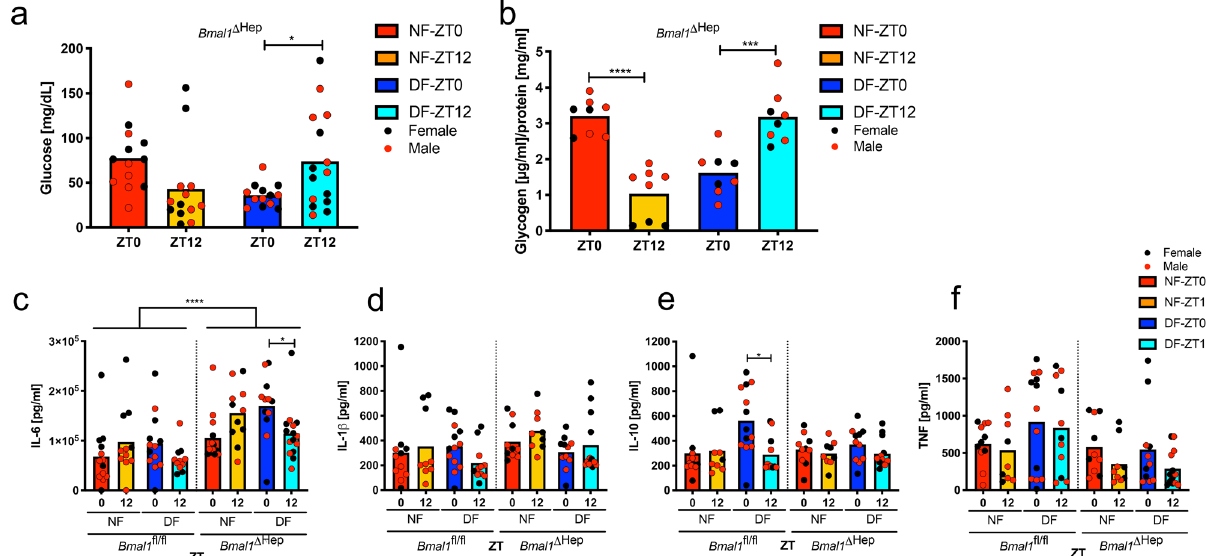
Fig. 5 Feeding-related glucose metabolism is liver-clock independent. a Serum glucose 6 h post LPS (20 mg/kg) stimulation at ZT0 or ZT12 as indicated on day 5 of TRF in Bmal1 Δ Hep . Female in black, male in red. NF-ZT0 N female = 6 N male = 7, NF-ZT12 N female = 6 N male = 7, DF-ZT0 N female = 6 N male = 7, DF- ZT12 N female = 8 N male = 7. Box indicates mean. Statistical analysis according to two-way ANOVA and Sidak ’ s multiple comparison (ZT0 vs. ZT12) as indicated. Interaction F (1,50) = 10.2, p = 0.0024, ZT F (1,50) = 0.02174, ns, Feeding F (1,50) = 0.2325, ns. * p = 0.0395. b Baseline liver glycogen content on day 5 of TRF at ZT0 or ZT12 in Bmal1 Δ Hep . Female in black, male in red. N female = 3 N male = 5. Box indicates mean. Statistical analysis according to two-way ANOVA and Sidak ’ s multiple comparison (ZT0 vs. ZT12) as indicated. Interaction F (1,28) = 64.45, p < 0.0001, ZT F (1,28) = 1.682, ns, Feeding F (1,28) = 1.431, ns. *** p = 0.0001 **** p < 0.0001. c – f Serum cytokines in Bmal1 Δ Hep or Bmal1 fl / fl 6 h post LPS stimulation (20 mg/kg) after 5 d of TRF at ZT0 or ZT12 as indicated. Box indicates mean. Female in black, male in red. Statistical analysis according to two-way ANOVA (within genotype) and Sidak ’ s multiple comparison (ZT0 vs. ZT12) as indicated. c Bmal1 fl / fl : ns. Bmal1 Δ Hep : Interaction F (1 , 47) = 11.12, p = 0.0017, ZT F (1,47) = 0.03561, ns, Feeding F (1,47) = 0.5365, ns. p * = 0.027. p < 0.0001 Bmal1 fl / fl vs. Bmal1 Δ Hep according to Mann – Whitney. Bmal1 Δ Hep : NF-ZT0 N female = 6 N male = 7, NF - ZT12 N female = 6 N male = 5, DF-ZT0 N female = 6 N male = 6, DF-ZT12 N female = 8 N male = 7. Bmal1 fl / fl : NF-ZT0 N female = 5 N male = 7, NF-ZT12 N female = 5 N male = 7, DF-ZT0 N female = 6 N = 7, DF-ZT12 N = 4 N = 7. d ns. e Bmal1 fl / fl : Interaction F = 4.435, p = 0.0415, ZT F = 3.31, ns, Feeding F = 2.803, ns. male female male (1,40) (1,40) (1,40) Bmal1 Δ Hep ns. p * = 0.0116. f Bmal1 fl / fl : ns. Bmal1 Δ Hep : Interaction F = 0.01987, ns, ZT F = 4.335, p = 0.0439, Feeding F = 01707, ns. d – f (1,39) (1,39) (1,39) Bmal1 Δ Hep : NF-ZT0 N = 5 N = 5, NF - ZT12 N = 4 N = 5, DF-ZT0 N = 5 N = 6, DF-ZT12 N = 7 N = 6. Bmal1 fl / fl : NF-ZT0 female male female male female male female male N = 5 N = 6, NF-ZT12 N = 3 N = 6, DF-ZT0 N = 6 N = 7, DF-ZT12 N = 4 N = female male female male female male female male